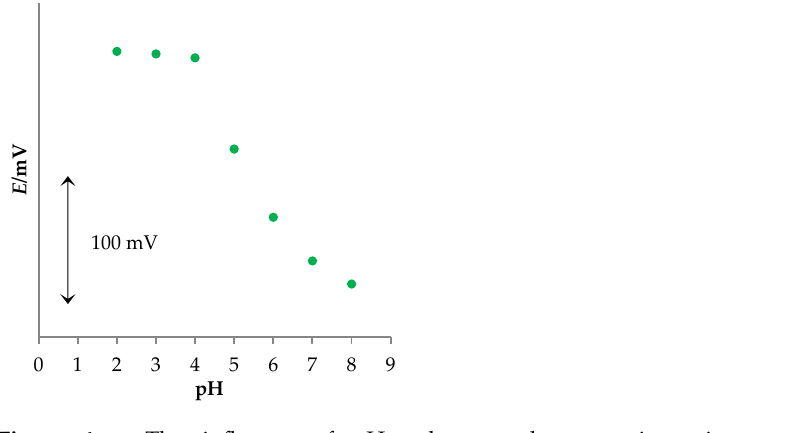
Figure 4. The influence of pH value on the potentiometric response of the new MWCNT-OSO 3 − TBZ + sensor.